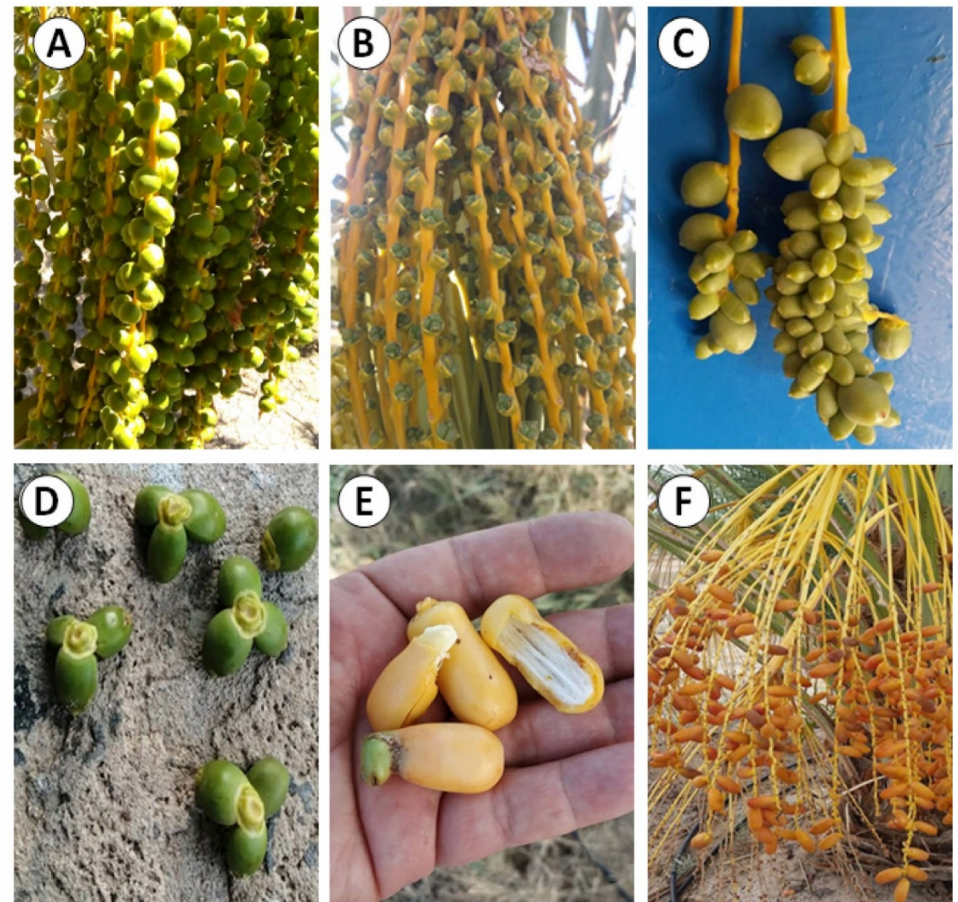
Figure 7. Parthenocarpic fruit in the date palm. ( A ) Date fruits resulting from good pollination. ( B , C ) Parthenocarpic date fruits resulting from naturally pollinated inflorescences, low compatibility between the male and female palms, or pollination outside the receptive time of the female inflorescence. ( D ) Fruit aborted with triplet parthenocarpic fruits. ( E , F ) Ripe dates lacking seeds, due to parthenocarpy.